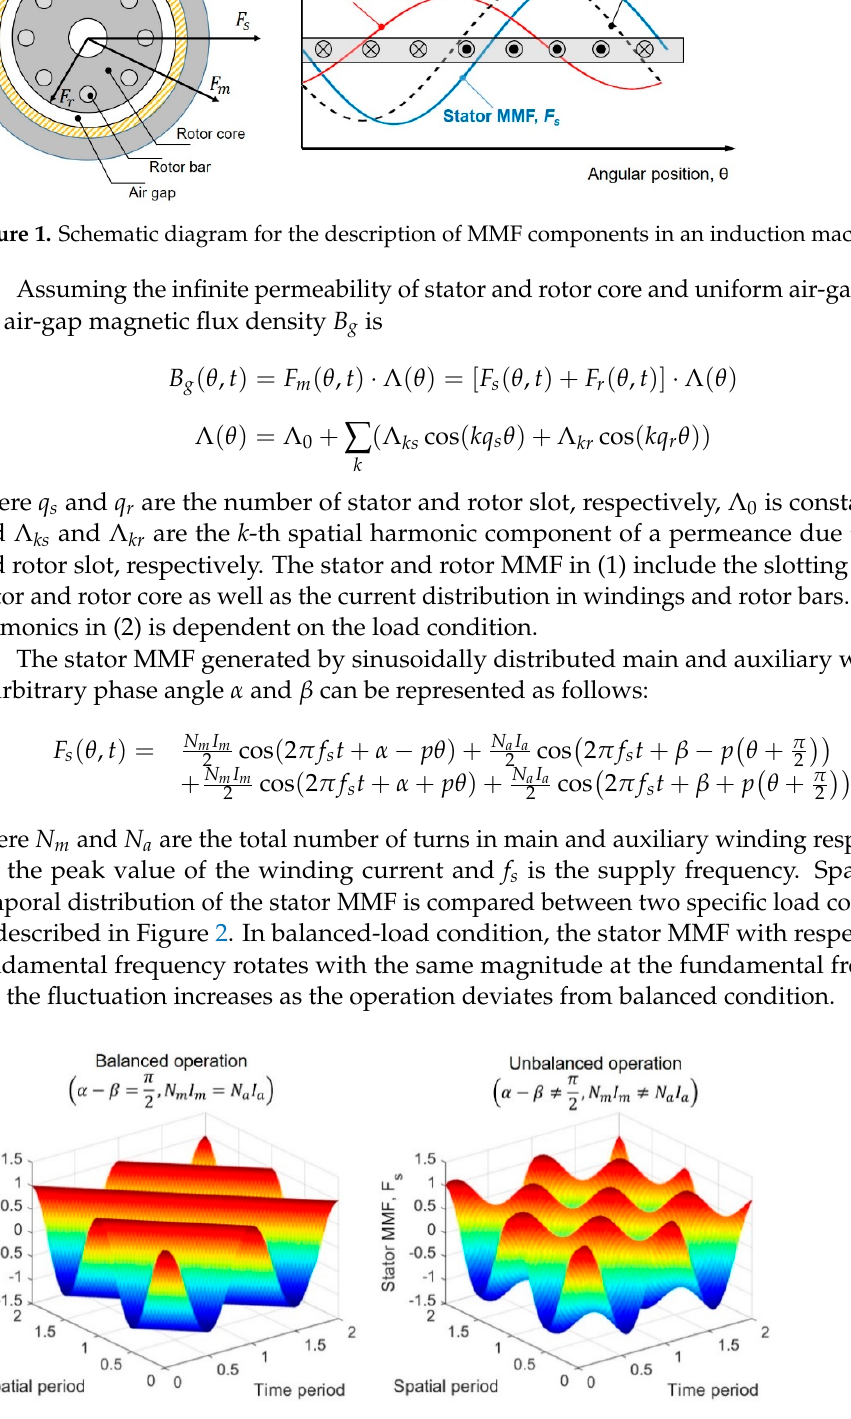
Figure 2. Spatial and temporal distribution of stator MMF at the balanced and unbalanced opera- tion.